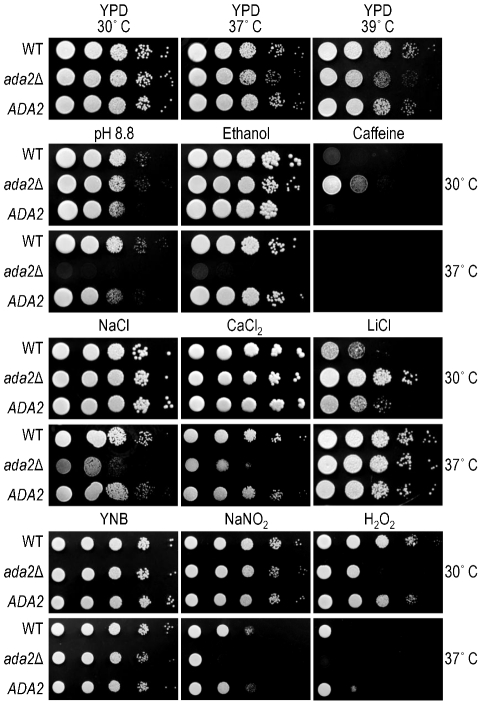
Ada2 is required for growth under certain stress conditions.Ten-fold serial dilutions of the indicated strains were grown in the conditions shown (see Methods for details). Top panel, growth on rich medium (YPD) at the temperatures indicated above the images; middle panels (four rows of images), growth on YPD with the indicated stressor at the temperatures shown at the right; bottom panel (two rows of images), growth on minimal medium (YNB) or YNB with the indicated stressor at the temperatures shown at the right.